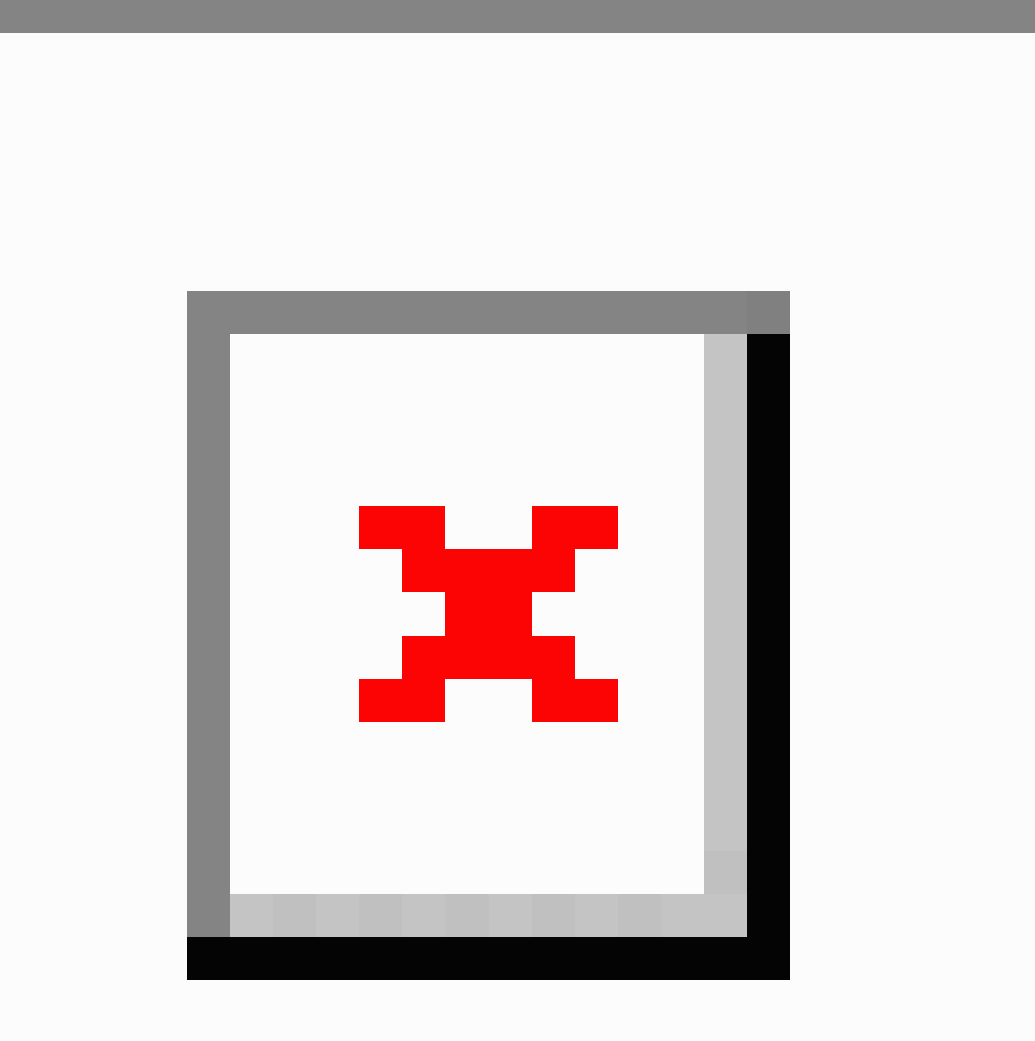
Figure 3. Illustration of the multi-sensor AM used to provide objective measures of resting heart rate and physical activity duration, frequency, and intensity to the PPAP